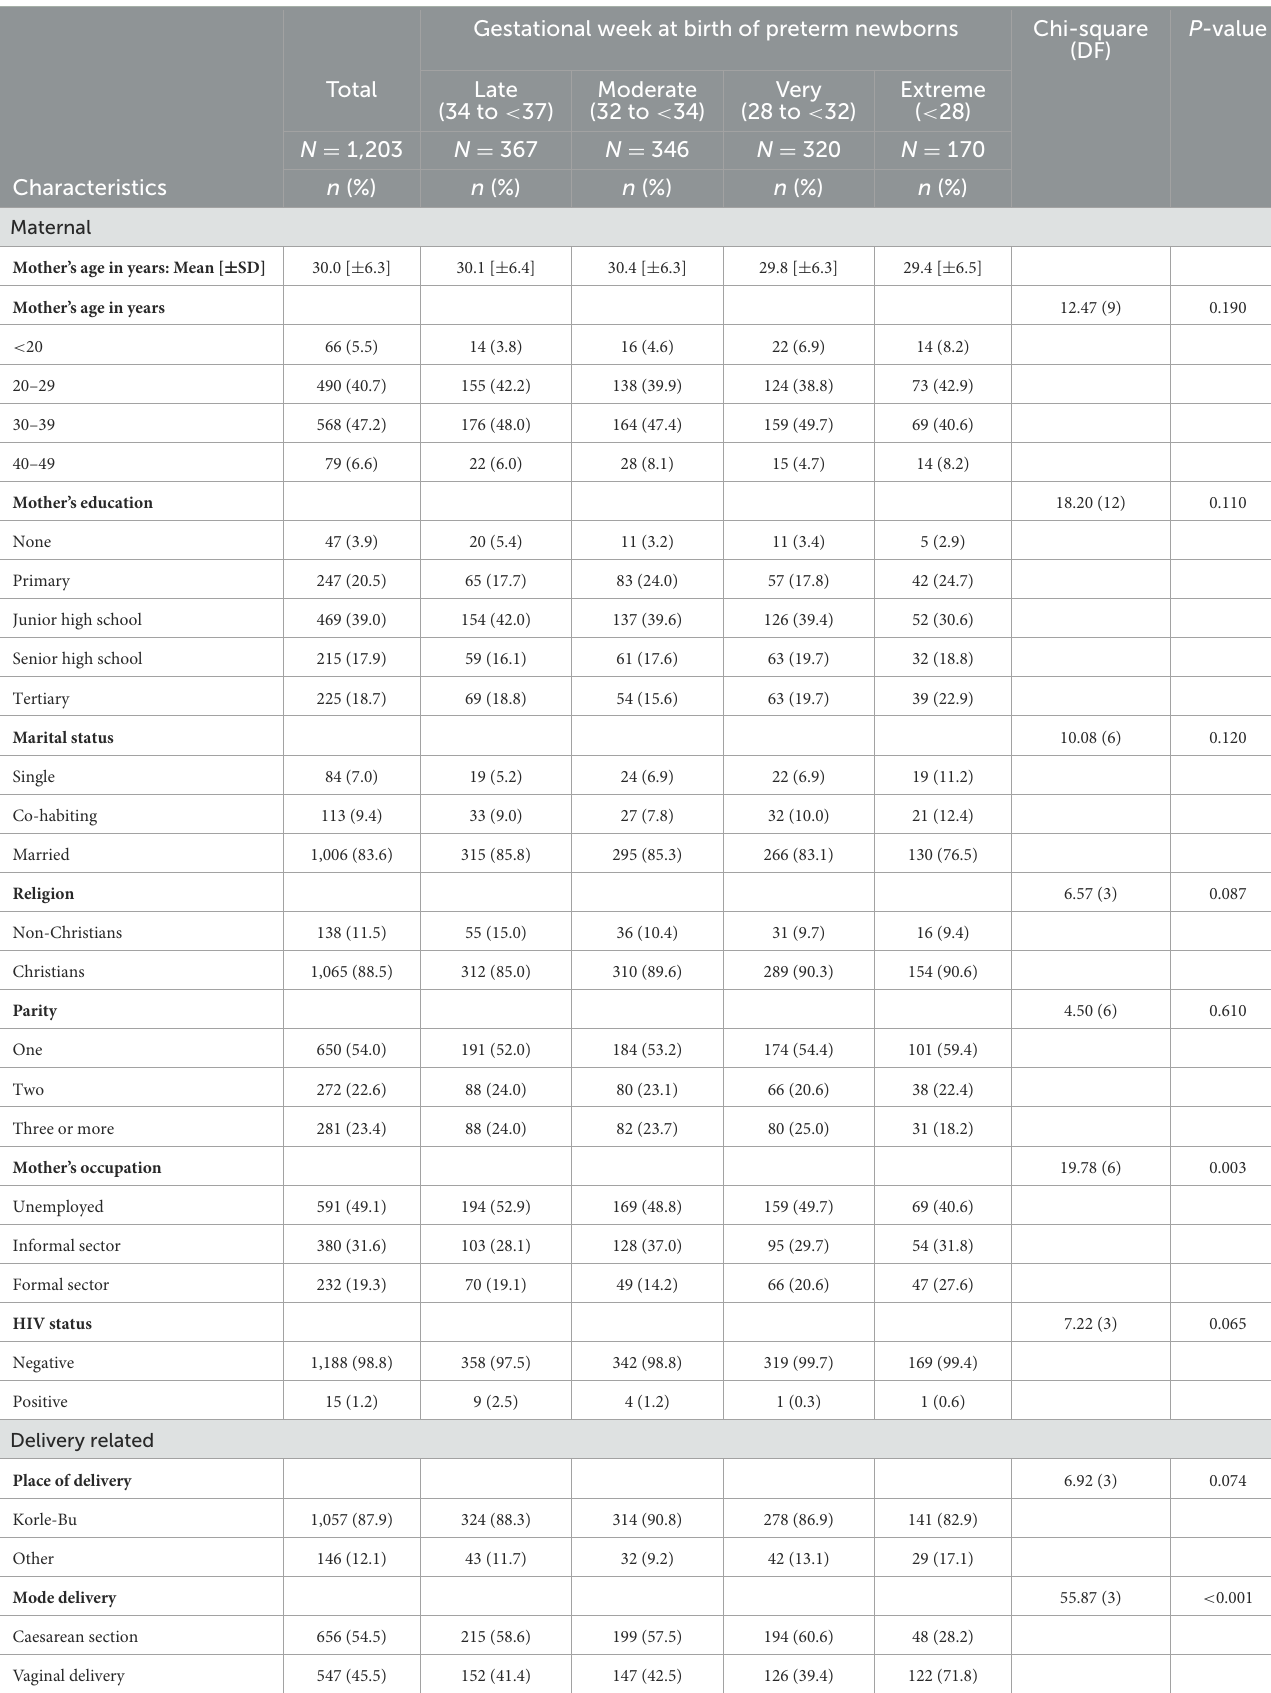
TABLE 1 Descriptive characteristics of child, maternal and delivery-related factors by gestational age at birth. Gestational week at birth of preterm